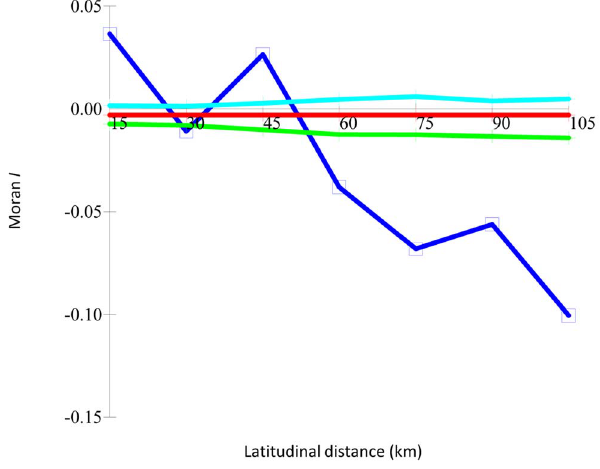
Figure 1. Autocorrelation analysis for latitudinal distances versus genetic distances using the 357 SL genotypes and 11 polymorphic SSR loci. Light blue line, upper limit, and green line, lower limit, of 99% probability envelopes; dark blue line, observed data.